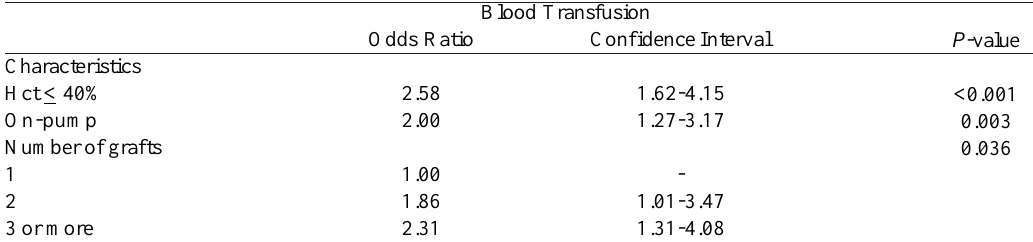
Table 3. Transfusion risk according to multivariate regression logistic analysis of perioperative variables associated with blood